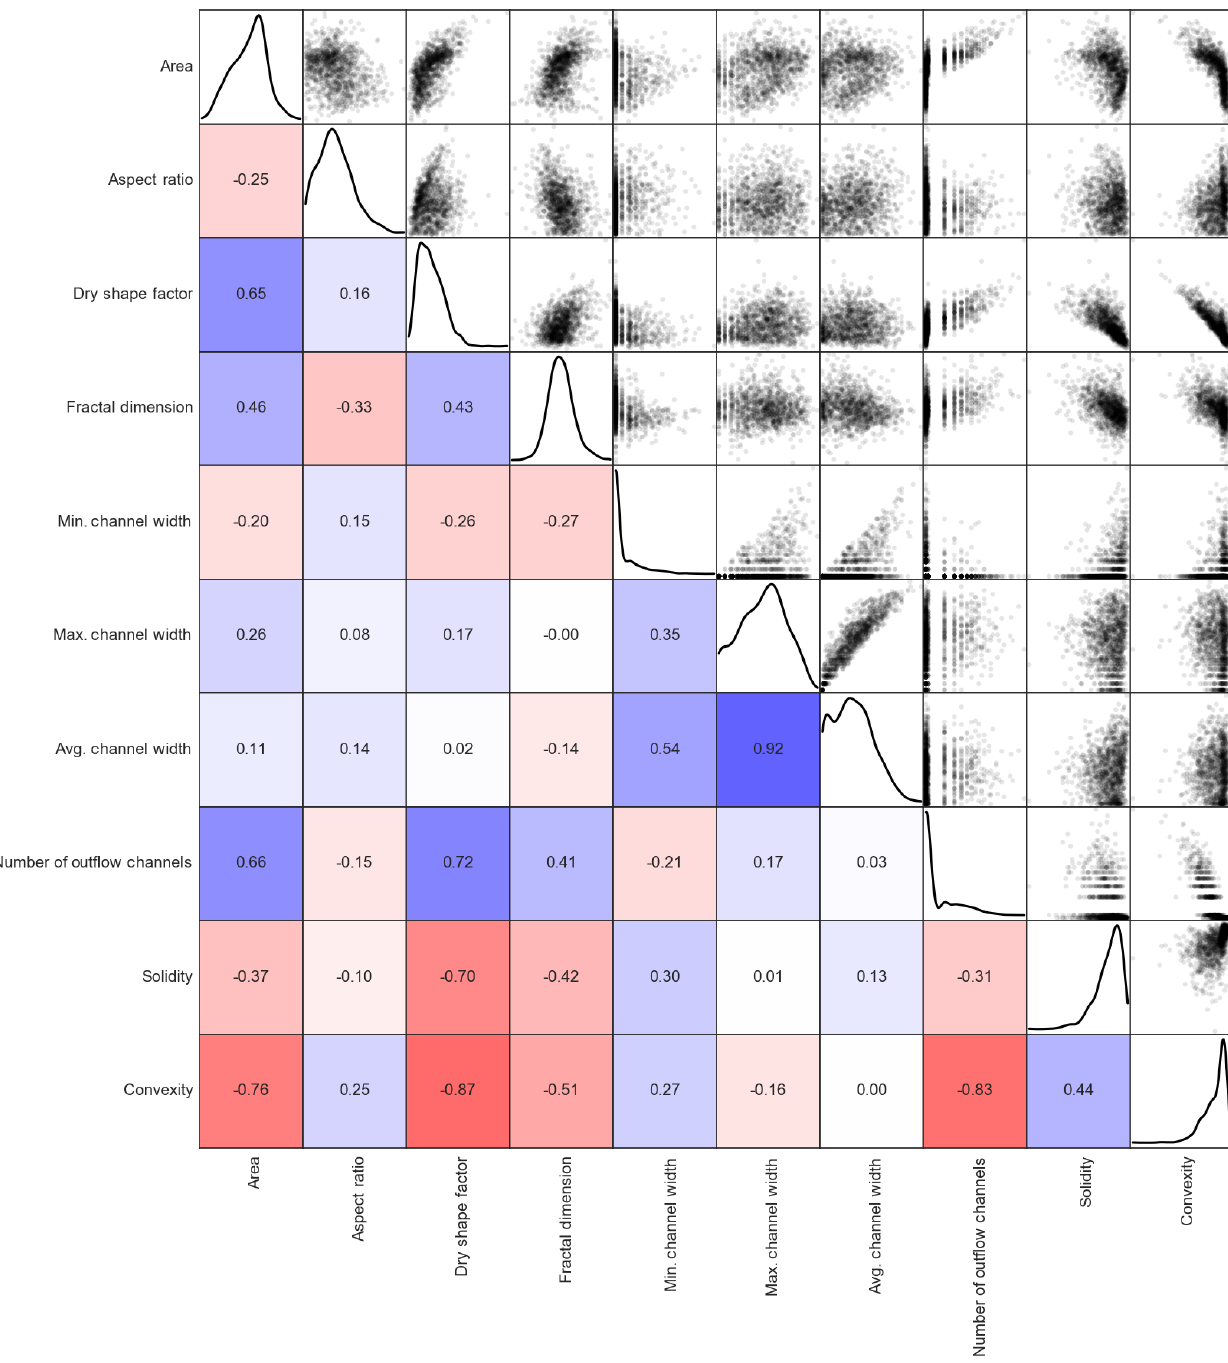
Figure 4. Matrix of correlation values for sets of metrics. Warm colors indicate pairs of metrics that are negatively correlated. Darker warm colors indicate stronger negative correlation relationships (e.g., the convexity–dry shape factor element). Cool colors indicate pairs of metrics that are positively correlated, with darker cool colors indicating stronger positive correlations (e.g., the average channel width–maximum channel width element). Overall, metrics used in this analysis show moderate degrees of correlation. Also shown are the distributions for each metric (e.g., the area–area element) as well as the scatter plot distribution of the metric relationships (e.g., the area–aspect ratio